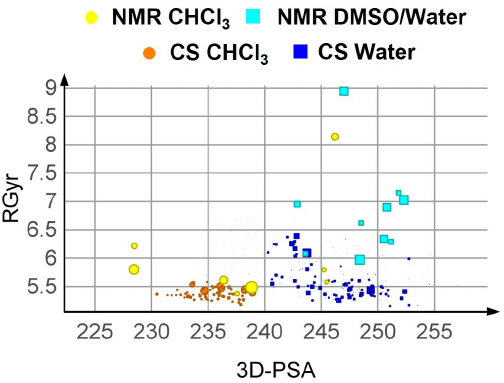
Figure 5. Comparison between CS (Sc05, weighted scheme) and the NMR results.